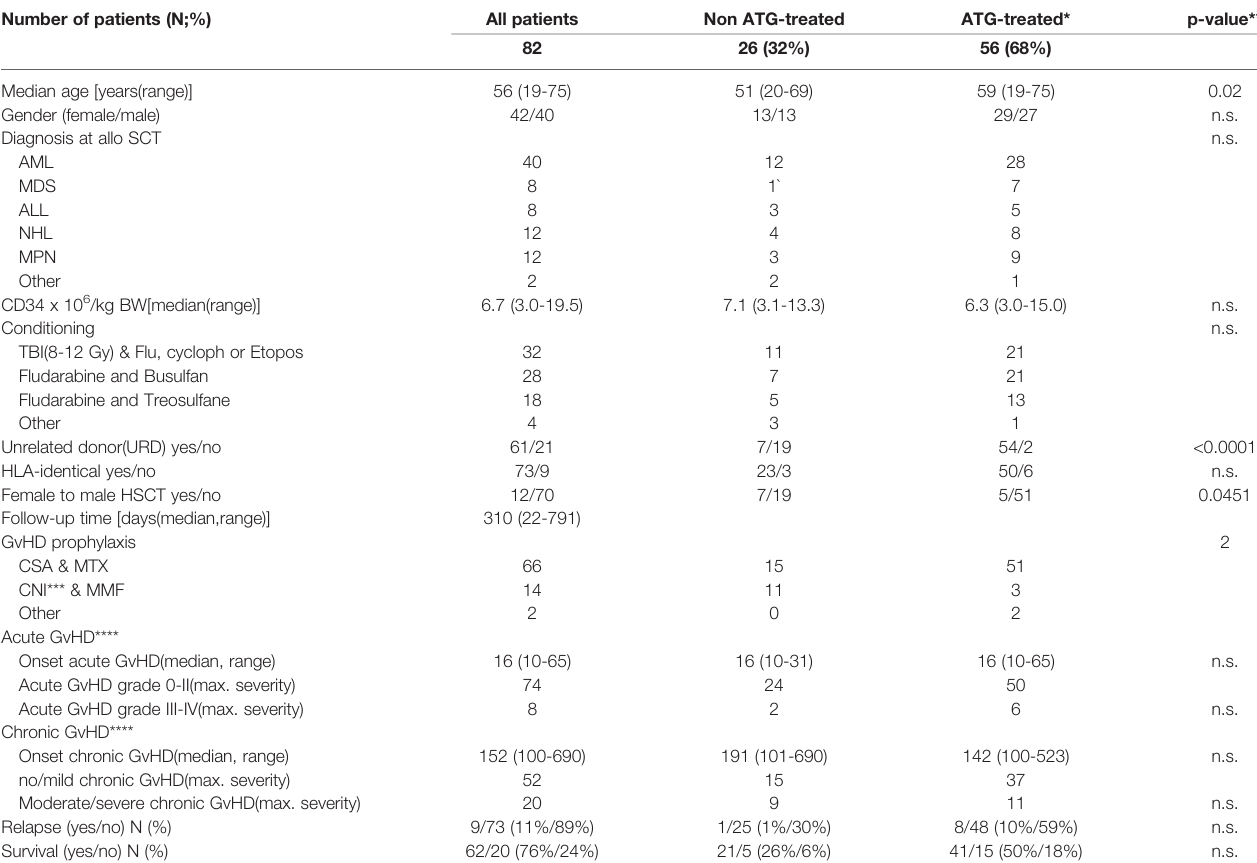
TABLE 1 | Demographic and HSCT characteristics of patients. Number of patients (N;%) All